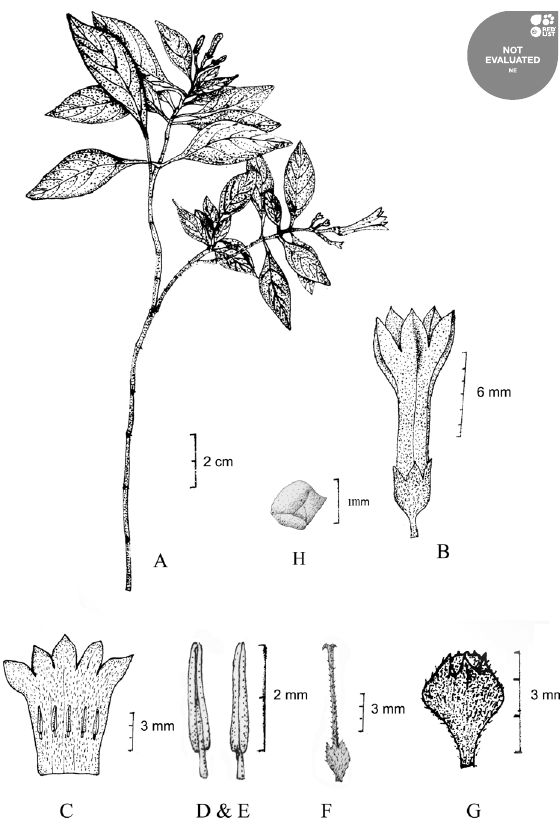
Figure 1. Ophiorrhiza pykarensis Gamble. A - Habit with inflorescence; B - Flower; C - Corolla split opened; D & E - stamens (abaxial and adaxial views); F - Pistil; G - Fruit; H - Seed (Drawn by V.S. Hareesh). Image 1. Herbarium of Ophiorrhiza